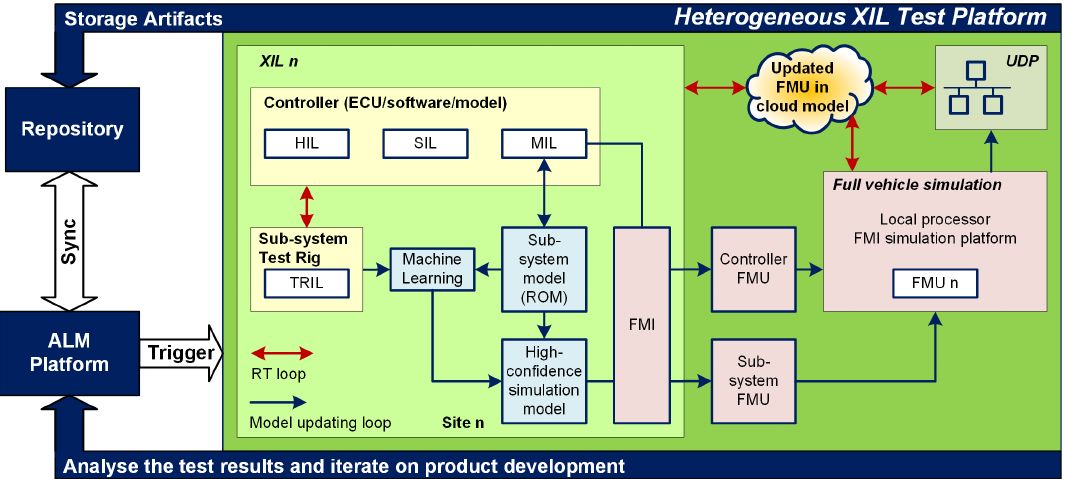
Figure 6. A variant of local XIL architecture with high-fidelity